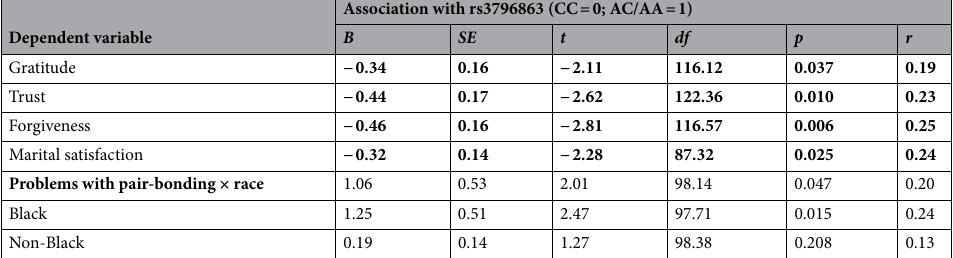
Table 1. Primary analyses: associations between CD38 rs3796863 and bonding-relevant cognitions. The dependent variables are standardized. Bolded effects are significant when correcting for multiple comparisons using the Benjamini–Hochberg procedure 54 . None of the effects were moderated by sex. For problems with pair-bonding, the effect appeared to be moderated by participant race so we are not interpreting the simple effect as